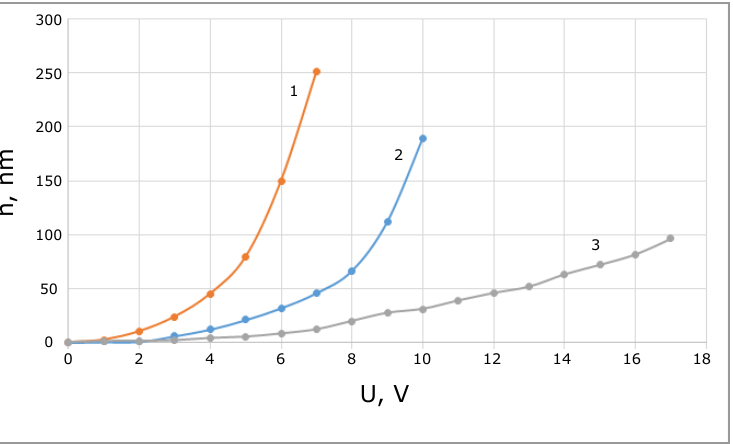
Figure 6. Membrane bias when voltage is applied for different feet widths of 15, 30 and 100 µ m are shown by solid lines marked by 1 (orange), 2 (blue), and 3 (grey), respectively. Increasing the width of the feet increases the stiffness of the membrane and therefore decreases its sensitivity and maximum bias but simultaneously increases the maximum working voltage and the voltage region of the linear response. The use of narrow legs enables sufficiently change the membrane sensitivity by the applied voltage, but it requires operation with low level signals for maintaining linear response. The use of a membrane with solid feet allows maintaining linearity even with sufficiently large signals. Figure 7 shows a comparison of two membranes with the same geometric parameters, but different membrane thicknesses 0.4 and 1 µ